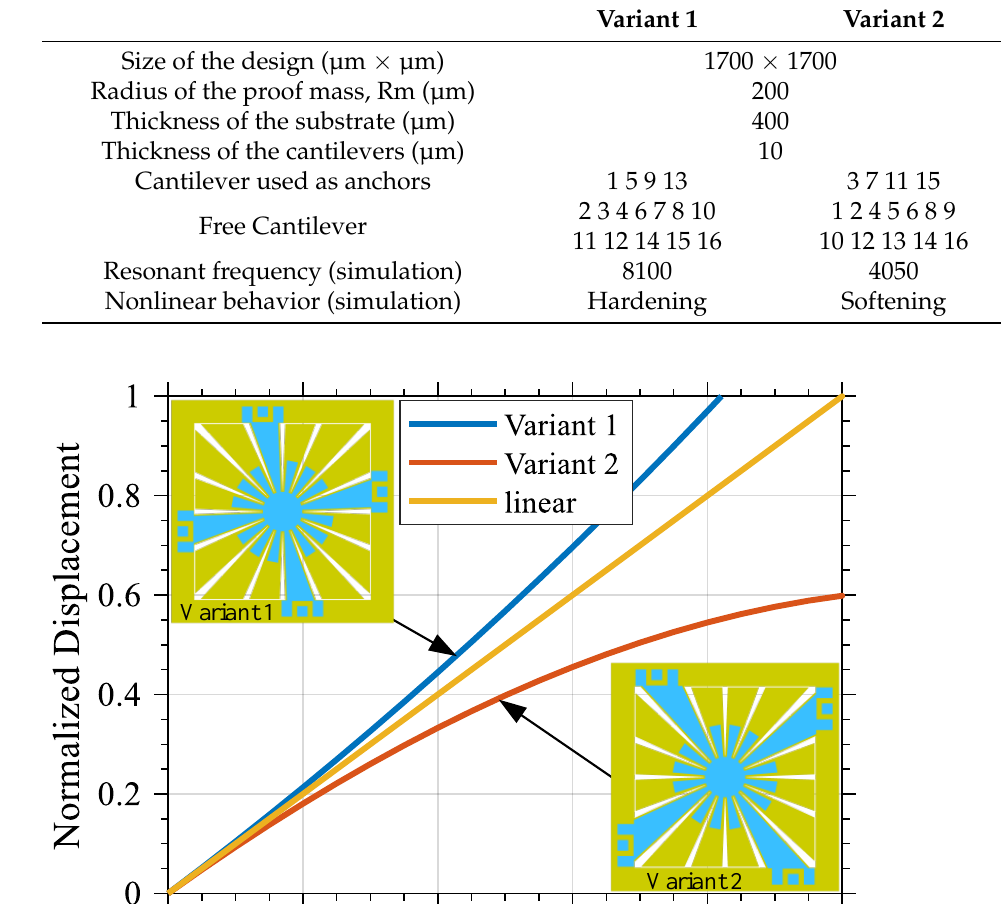
Table 1. Overview of the parameters for each of the SD resonator design variants.